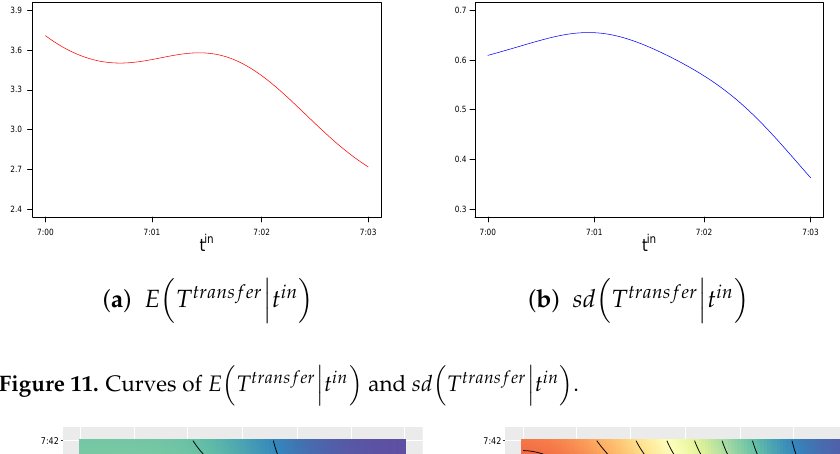
Figure 11. Curves of E